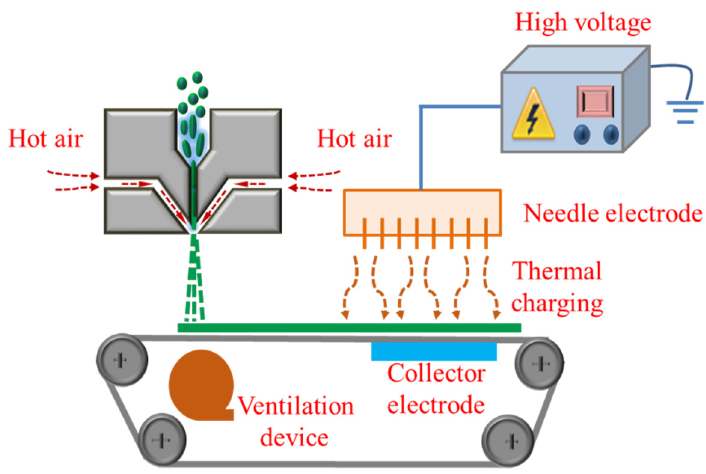
Figure 1. Schematic of the fabrication procedure of charged polypropylene (PP) melt blown nonwovens. Table 1. Melt blowing process parameters .